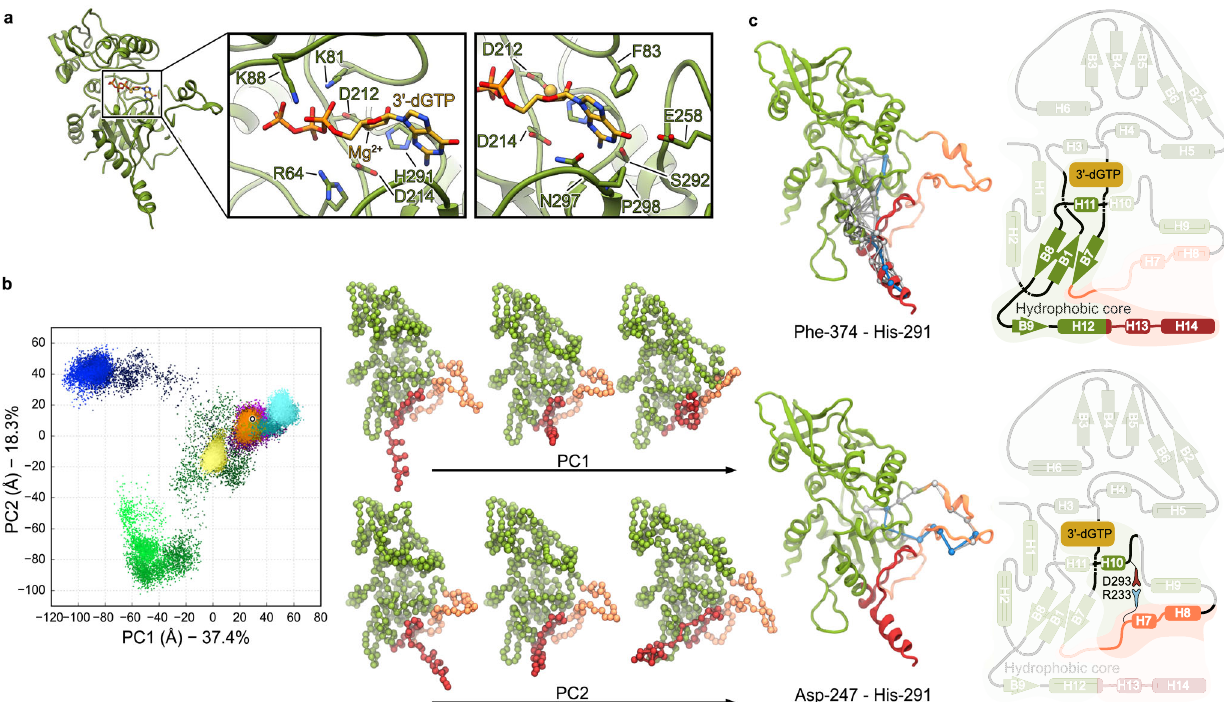
Fig. 2 Effect of F-actin binding on the structure of PaExoY. a Atomic model of the PaExoY with focus on the nucleotide-binding pocket (NBP). b Principal component (PC) analysis of the different simulations. Each point represents a conformation projected onto the fi rst two principal components. For each trajectory, time progresses as the color goes from dark to bright. Blue and green correspond to free PaExoY, while yellow, cyan, orange, and purple correspond to the F-actin-PaExoY complex. The white dot represents the starting conformation for all simulations. The structures on the right from the plot show the nature of the variation along each component. c Collection of the paths (white) with the shortest possible path (light blue) connecting His-291 at the active site of PaExoY with different regions interacting with actin.